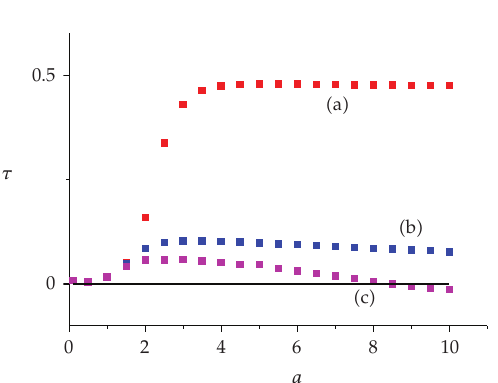
Figure 5: The tunneling time τ as a function of the barrier depth a , for di ff erent values of Δ k : (cid:2) a (cid:3) Δ k (cid:6) 0 . 01 ˚A, (cid:2) b (cid:3) Δ k (cid:6) 0 . 05 ˚A, and (cid:2) c (cid:3) Δ k (cid:6) 0 . 1 ˚A.